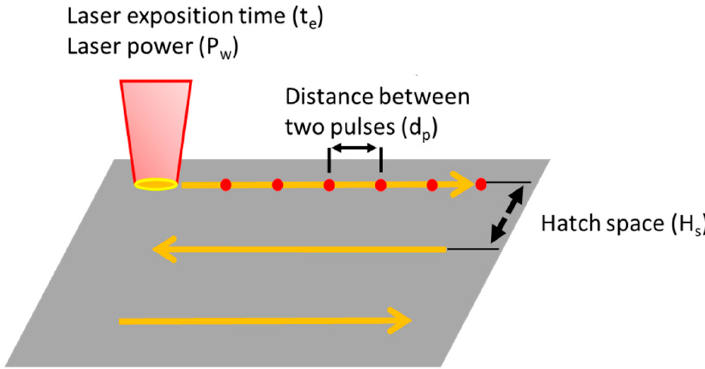
Figure 3. Schema of the different laser melting parameters selected to variate.